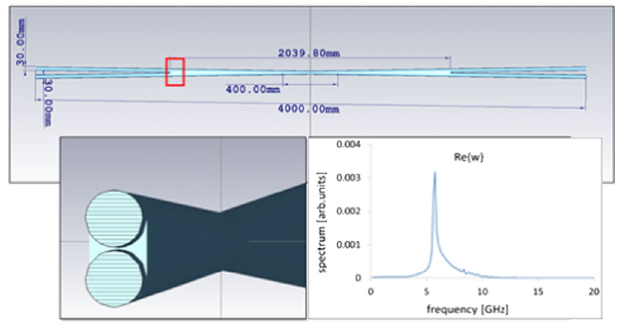
FIG. 9. Geometry of the IR model 2. The cross section near the pipe connection shows two small sharp transitions to the elliptical shape. The spectrum of the exited fields in this model is shown in right lower plot.